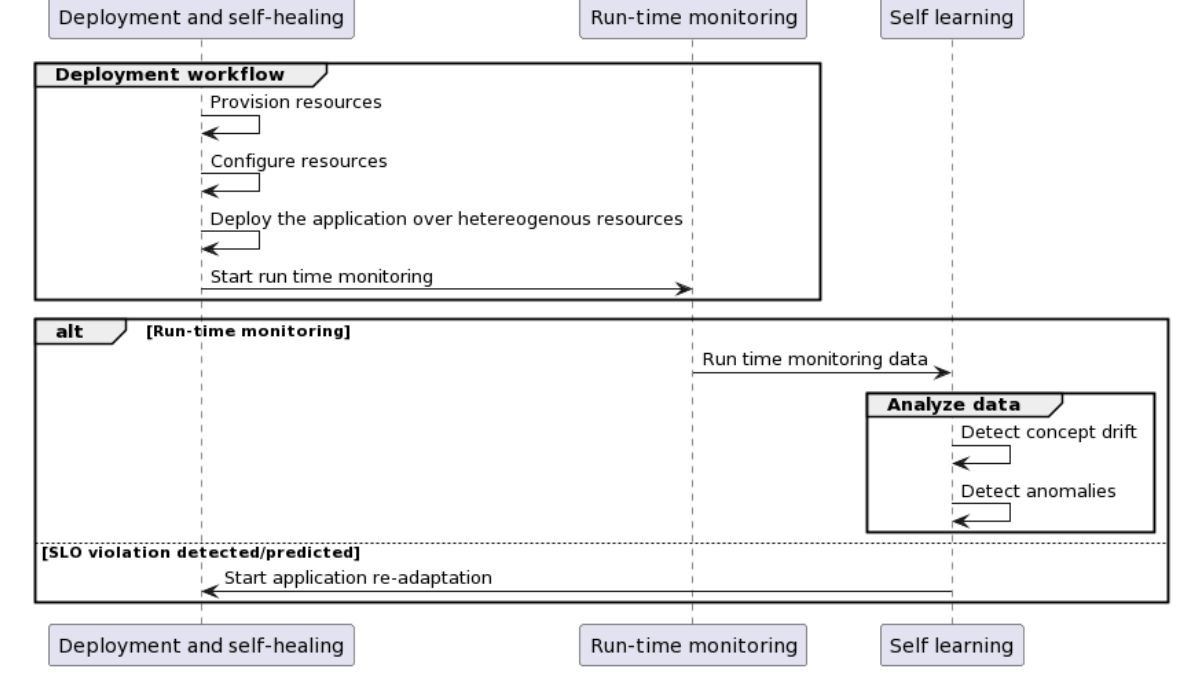
Figure 5. Sequence diagram of the proposed Cloud Deployment workflow through the refer- ence